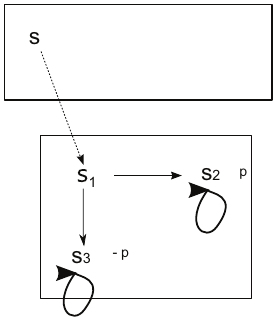
Figure A1. Unawareness without